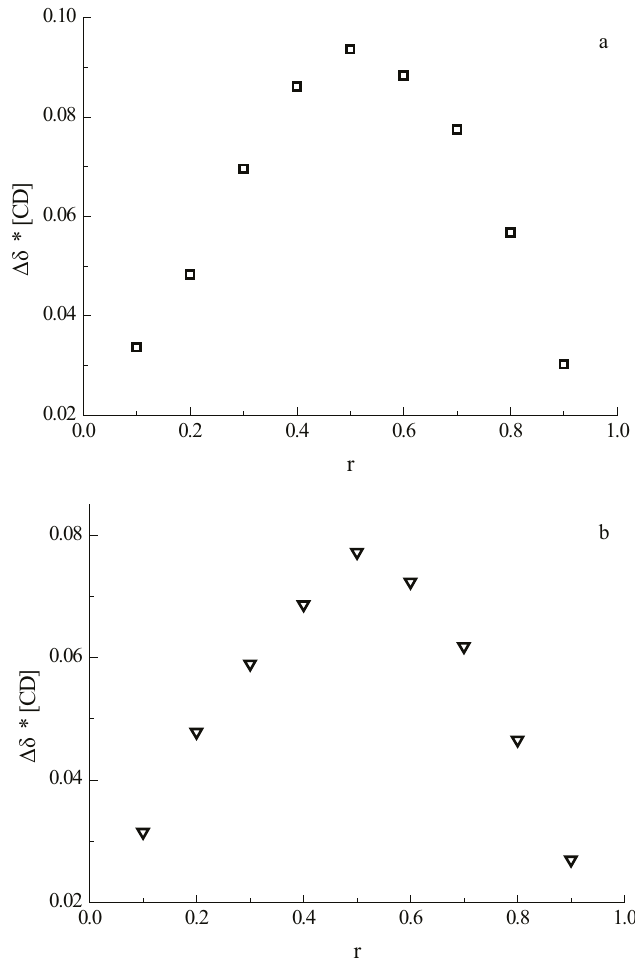
Figure 2. Job’s plot using the chemical shift of the H-5 signal of β -CD of ( a ) the complex of daidzein with β -CD; ( b ) the complex of daidzin with β -CD. “r” is the molar fraction of β -CD in the guest/ β -CD mixture.